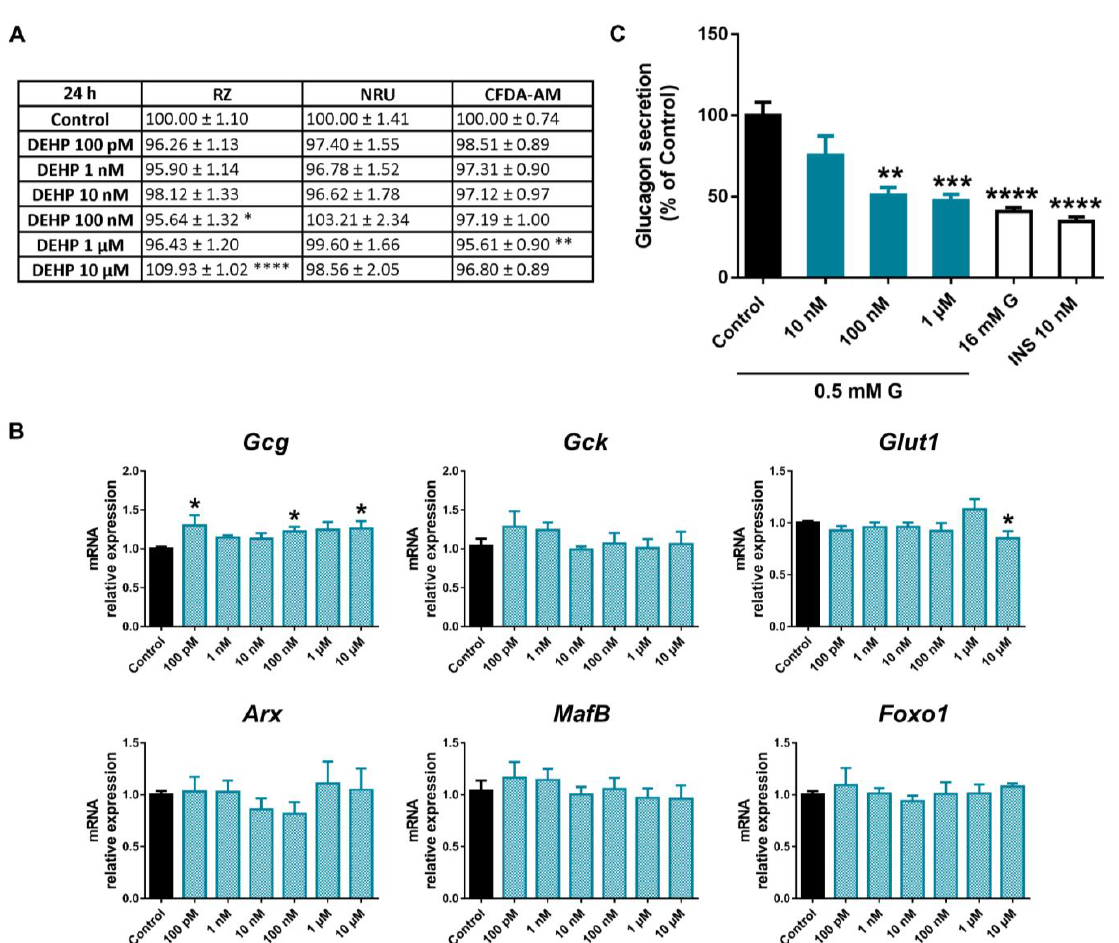
Figure 6. DEHP effects on pancreatic α -cells. ( A ) Viability of pancreatic α TC1-9 cells treated for 24 h with different concentrations of DEHP (100 pM–10 µ M) as evaluated by RZ, NRU, and CFDA-AM assays. Results are expressed as % of the solvent controls (Control = 100%). ( B ) mRNA expression of Gcg , Gck , Glut1 , Arx , MafB , and Foxo1 in control- and DEHP-treated α TC1-9 cells for 24 h. ( C ) Glucagon secretion in α TC1-9 cells treated for 24 h with DEHP. Data are represented as mean ± SEM of ( A ) n = 3, ( B ) n =